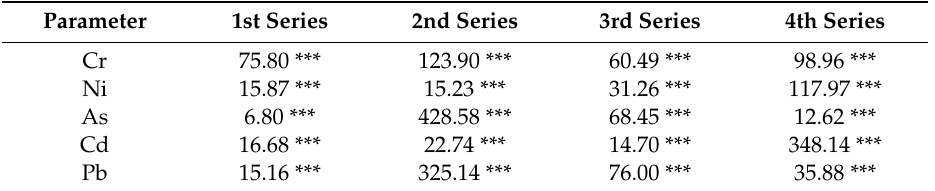
Table 1. One-way ANOVA results ( F statistics) of element accumulation in leaves at six sites (including